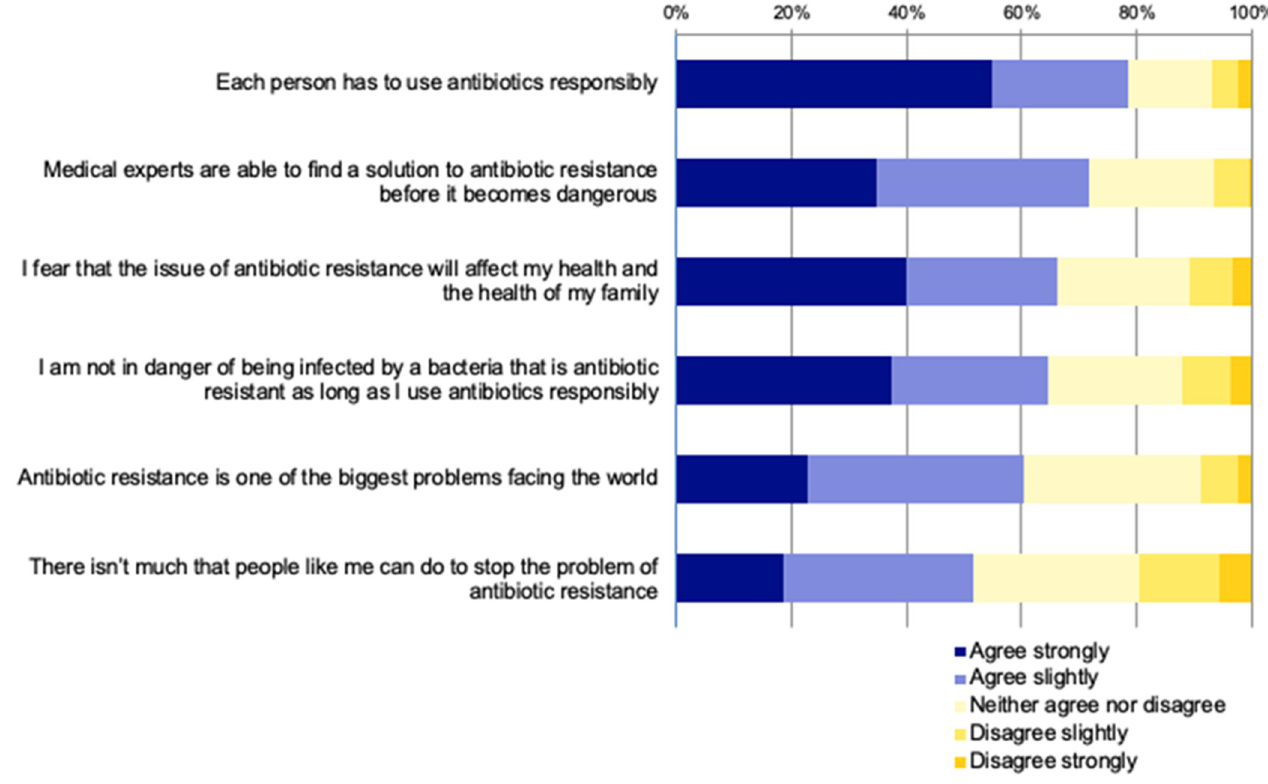
Fig 3. Participants’ attitudes towards the importance of the issue of antibiotic resistance.